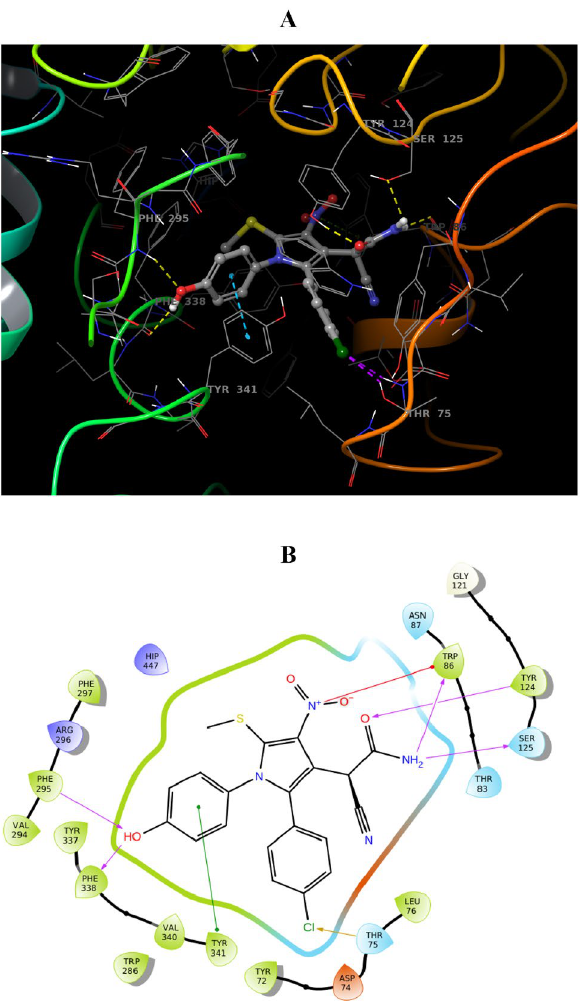
Figure 9. ( A ) 3D Binding pattern of 4ad within the active site of AChE, ( B ) 2D binding interactions 4ad in AChE active